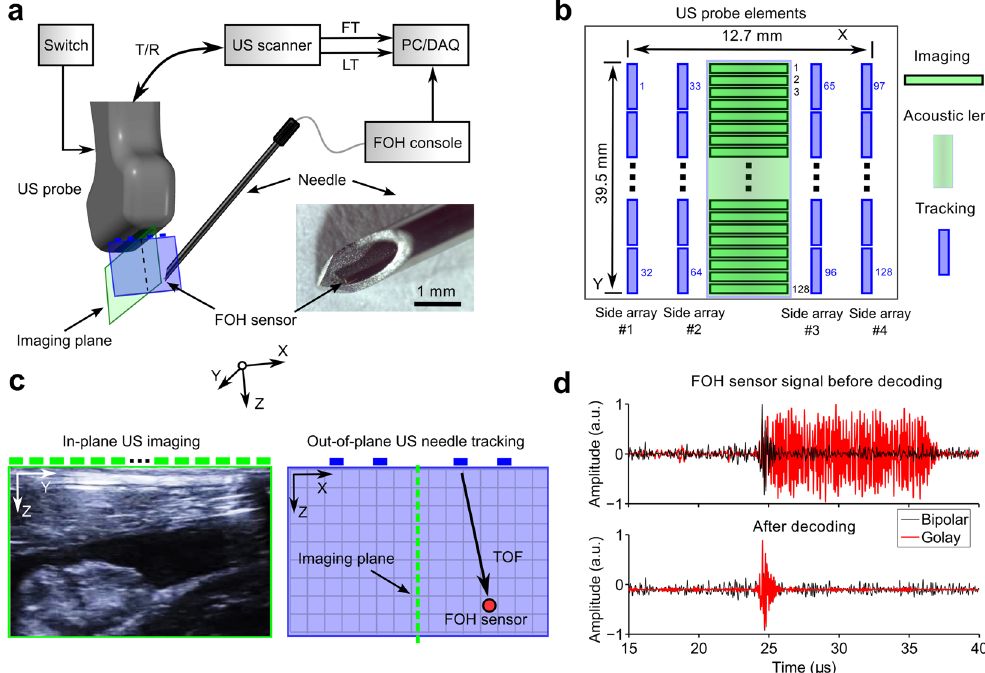
Figure 1. System overview. ( a ) Schematic showing the ultrasound (US) imaging/tracking probe developed in this study that allows for 2D US imaging and 3D needle tracking. A switch allowed for rapid electronic selection of transducer elements for imaging or those for tracking. The probe was driven by a commercial US scanner that allowed for control over transmissions from individual tracking elements. A fibre optic hydrophone (FOH) sensor, positioned within the lumen of a 20 gauge needle, received tracking transmissions. T/R: transmit/receive; LT: line trigger; FT: frame trigger; PC: personal computer; DAQ: digital acquisition card. ( b ) Transducer element layout of the probe: a focused central array was used for imaging (128 elements); side arrays, for tracking (32 elements per row; 128 elements in total). ( c ) Information derived from the transducer arrays: a sample B-mode US image acquired with the central array; a transmission from a side array element received by the FOH sensor is shown schematically. TOF: time-of-flight. ( d ) Coded excitation scheme: raw signals received by the FOH sensor corresponding to a Golay transmission and a bipolar pulse (top); decoded signal from a Golay transmission pair and a raw bipolar pulse are shown for comparison